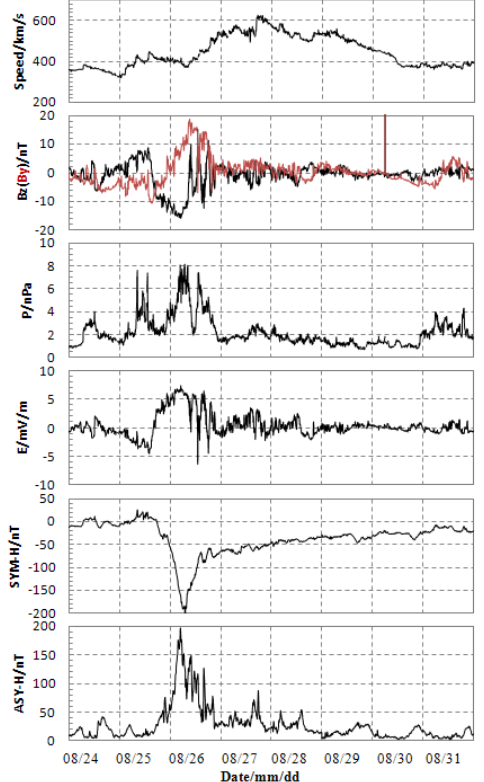
Figure 1. The geomagnetic indices curves from 24 to 31 August in 2018 (from top to bottom are respectively flow speed, interplanetary magnetic field (IMF) Bz (black line) and By (red line), flow pressure, interplanetary electric field (IEF) Ey, SYM-H index, and ASY-H index; all these parameters are published at the website of https://omniweb.gsfc.nasa.gov/form/omni_min.html, accessed on 8 August 2022).